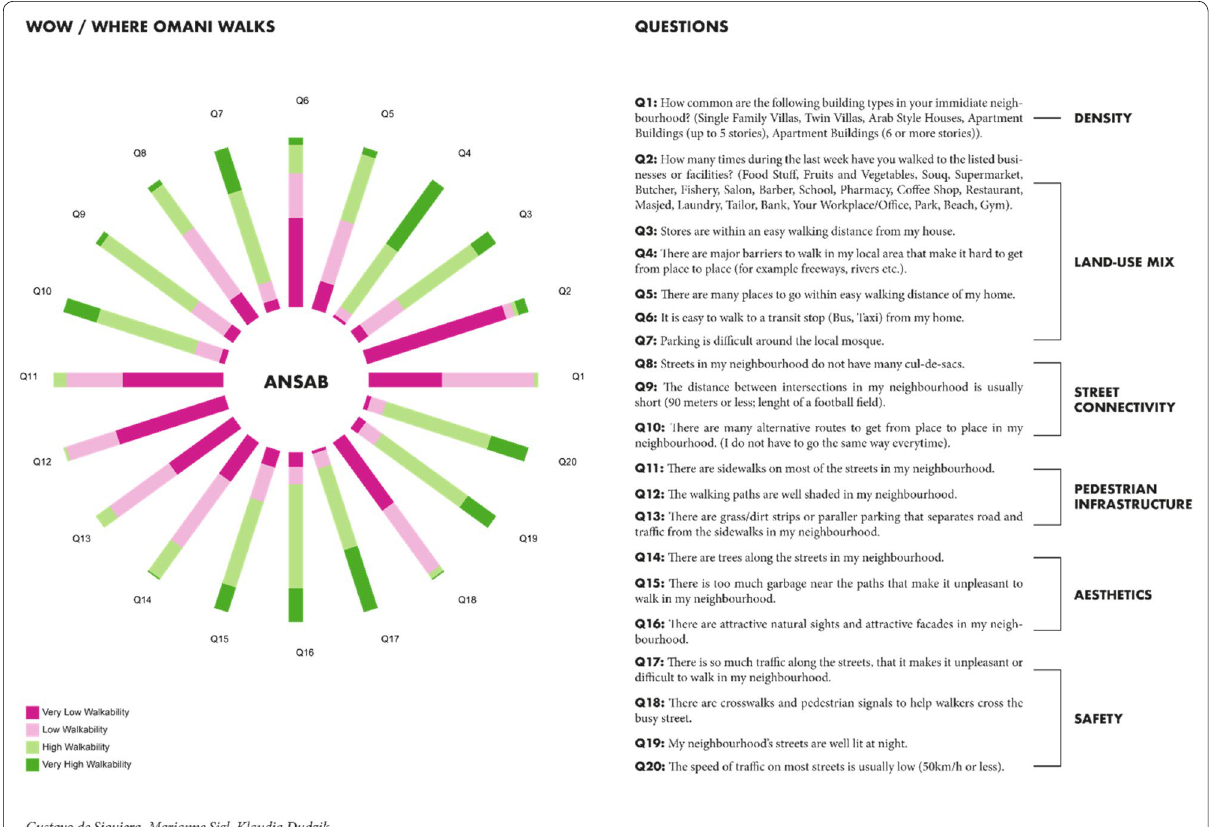
Fig. 5 Results of surveys on perceived walkable attributes in the neighborhood of Al Ansab in